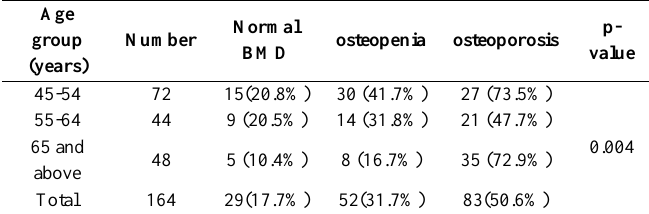
Table 2 : Distribution of BMD (by DXA) among post-menopausal